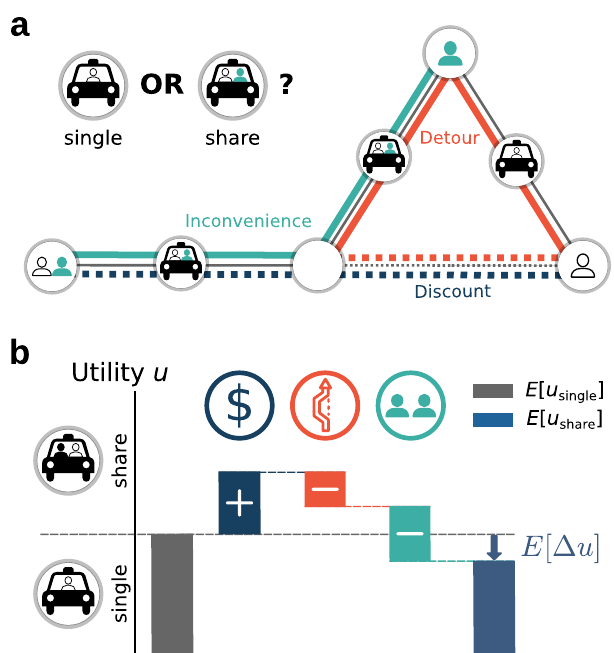
Fig. 2 Trade-offs between incentives determine the decision to share a ride, or not. a Shared rides offer advantages and disadvantages compared to single rides. On the one hand, they offer fi nancial discounts typically proportional to the distance of a direct single ride (blue, dotted). On the other hand, rides shared with strangers may include detours compared to a direct trip to pickup or deliver these other passengers (orange, solid compared to dotted) and may be inconvenient due to other passengers in the car (e.g., loss of privacy or less space, green). b The decision to book a shared ride depends on the balance of all three factors. If the expected utility difference E ½ Δ u (cid:3) ¼ E ½ u share (cid:3) (cid:2) E ½ u single (cid:3) between a shared and a single ride is positive, the fi nancial discounts overcompensate detour and inconvenience effects; users share. If E [ Δ u ] is negative (as illustrated), users prefer to book single